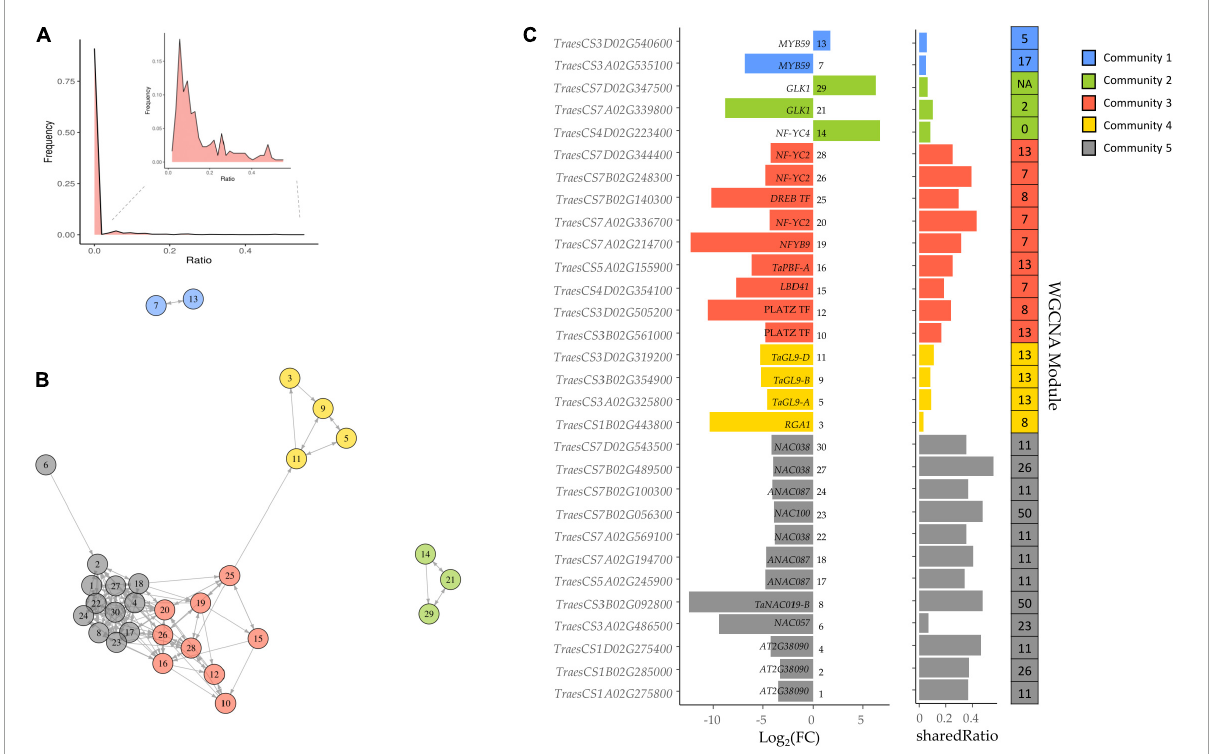
FIGURE4 (A) Frequency of shared genes between Gene Network Inference with Ensemble of trees (GENIE3) transcription factors (TFs) target genes and differentially expressed (DE) genes in the grain of E82 compared to the wild type (WT). For improving the representation of frequencies, we remove those TFs with zero shared genes in the insert. (B) Network of candidate TFs implicated in the protein and starch changes in the grain of E82. All these genes are DE TF with a shared Ratio > 0. The different colors represent the community of nodes detected based on greedy optimization of modularity. (C) Fold-change (FC) values and shared Ratio of each gene in the network. Gene name ( A. thaliana ortholog information) and network ID are represented in the plot. On the right, there is the module of the Weighted Gene Co-expression Network Analysis (WGCNA) network for grain tissue to which each TF